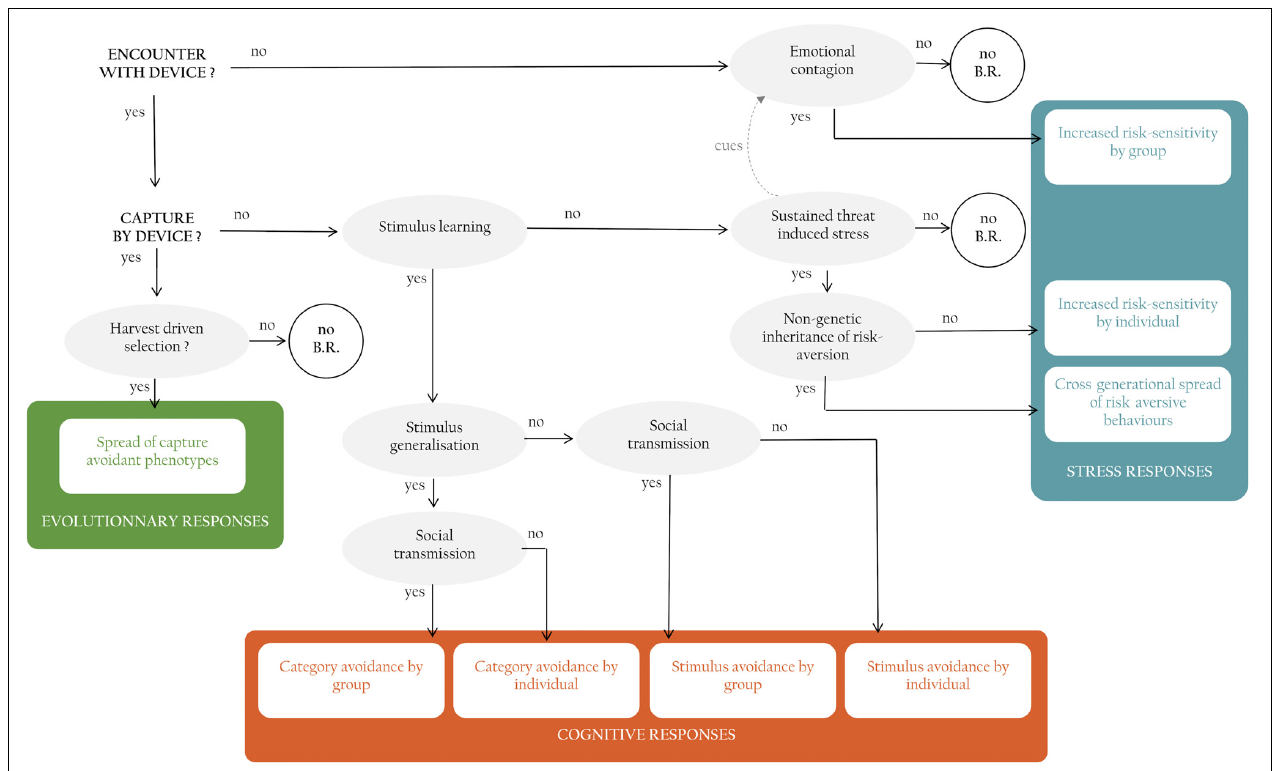
FIGURE 2 | Framework linking interactions of individuals with management devices (in bold black capitals), to mechanisms (in gray circles) to the different types of behavioral responses possible displayed by individuals, and/or populations (in colored boxes). Behavioral responses are grouped into three categories (see text), in some cases, combinations of events and mechanisms do not elicit a behavioral response (white circles with NO